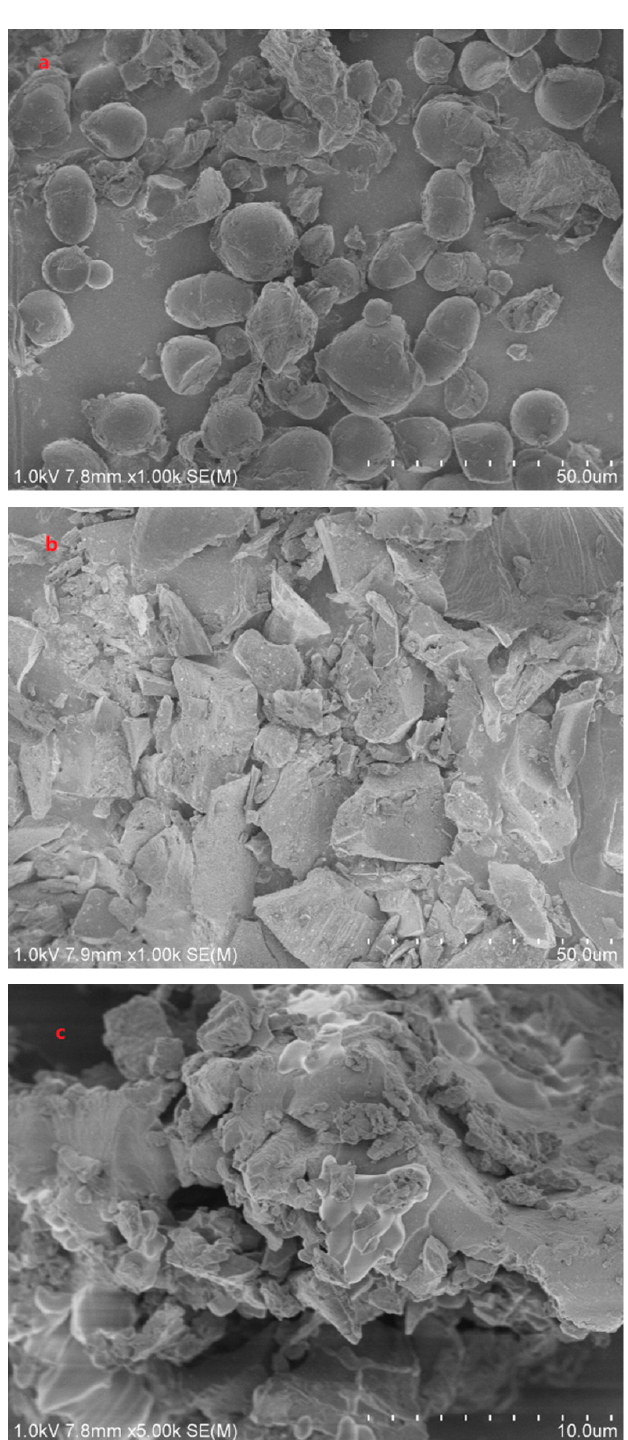
Figure 7. Scanning electron microscope (SEM) images of sweet potato ( a ); carbonized carrier ( b ) and sulfonated carbon ‐ based solid catalyst ( c ).